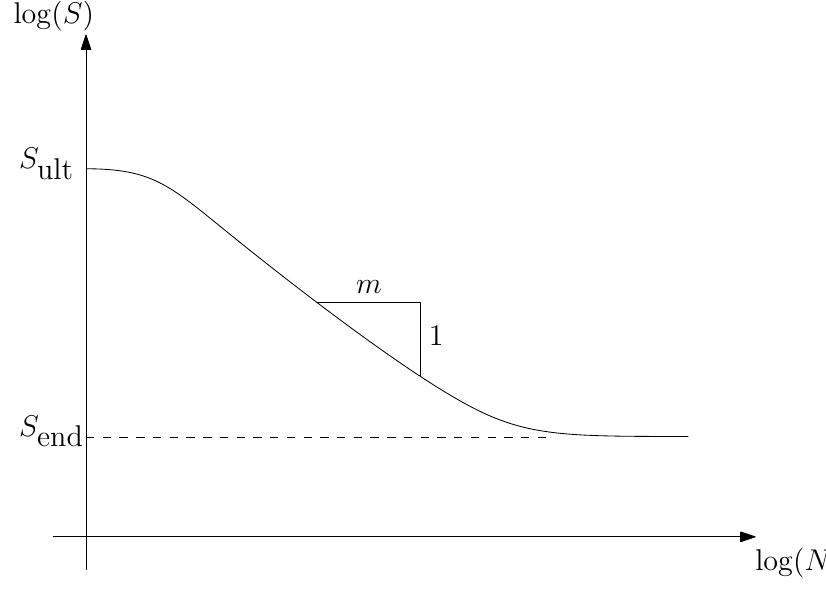
Figure 5. Typical S - N